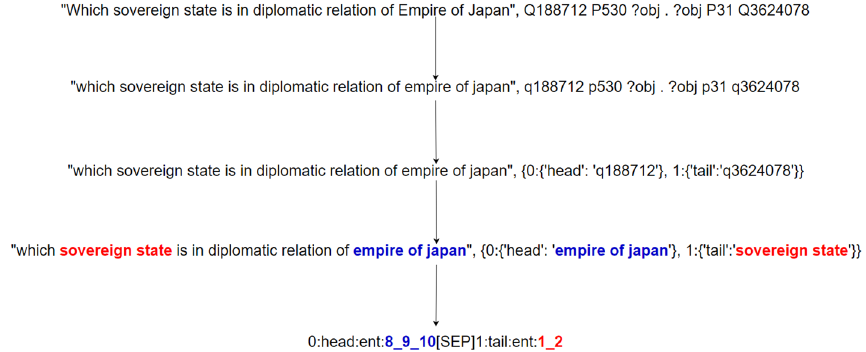
Fig. 5 Running example of position-based pattern set